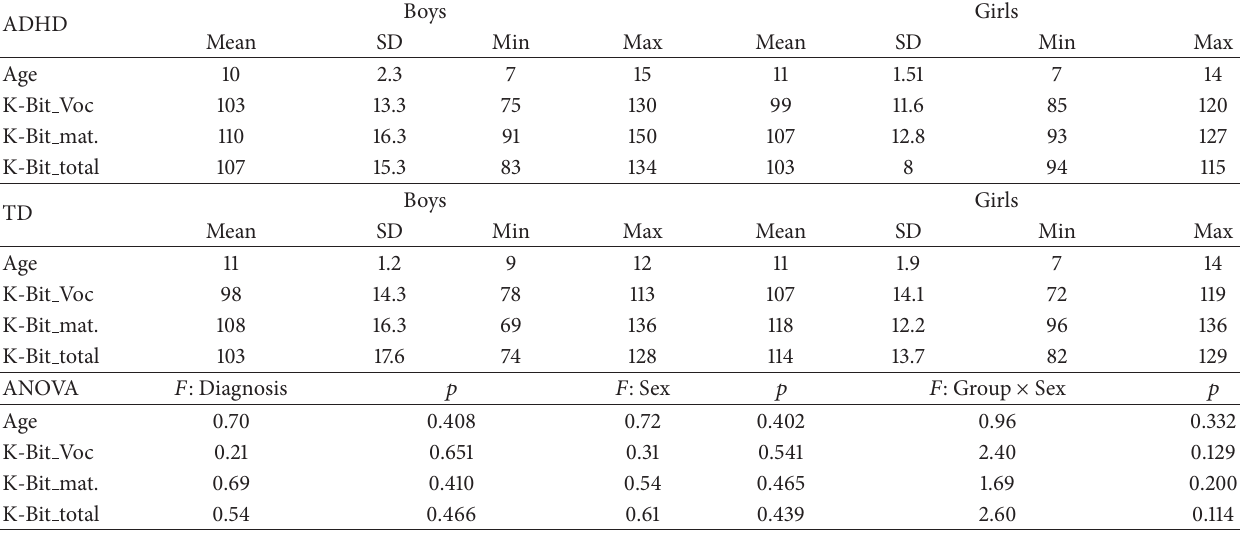
Table 1: Age and IQ of participants with ADHD and typically developing youth